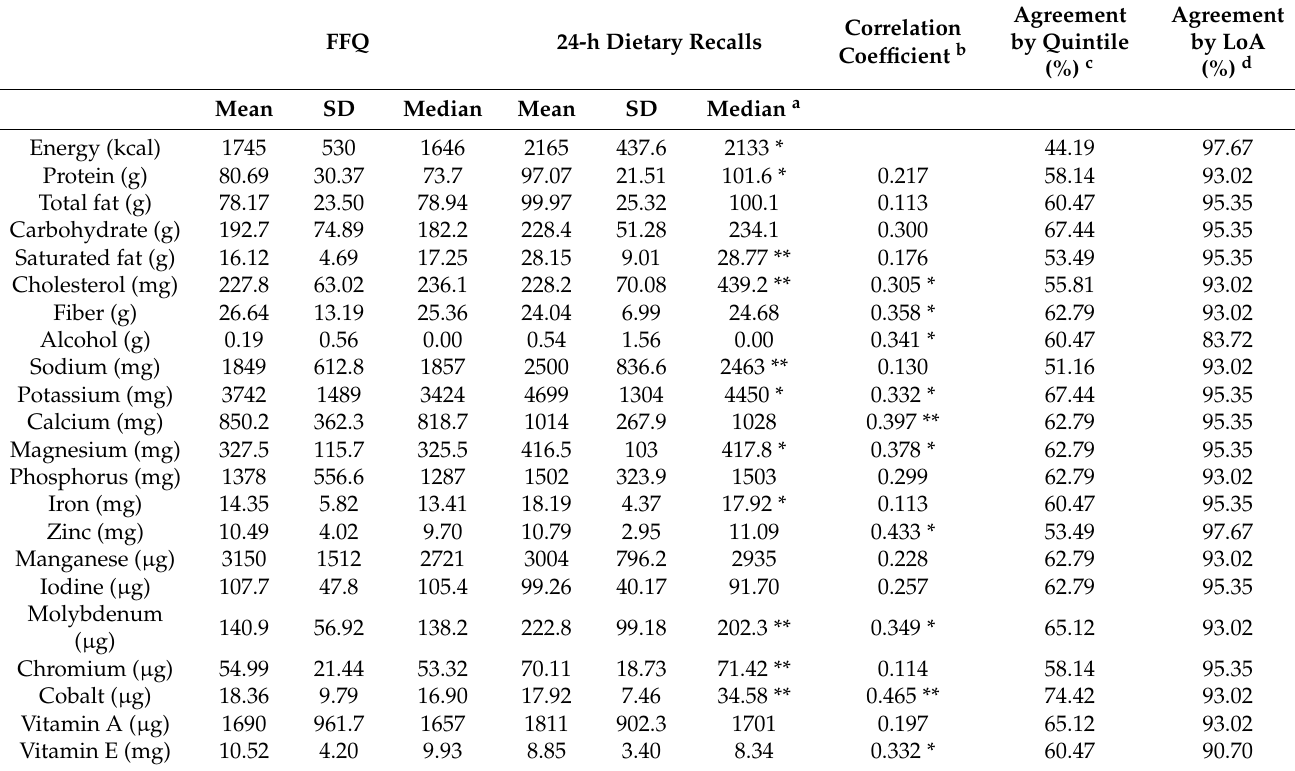
Table 4. Mean daily energy and nutrient intakes based on food-frequency questionnaire (FFQ) and 24-h dietary recalls (n =